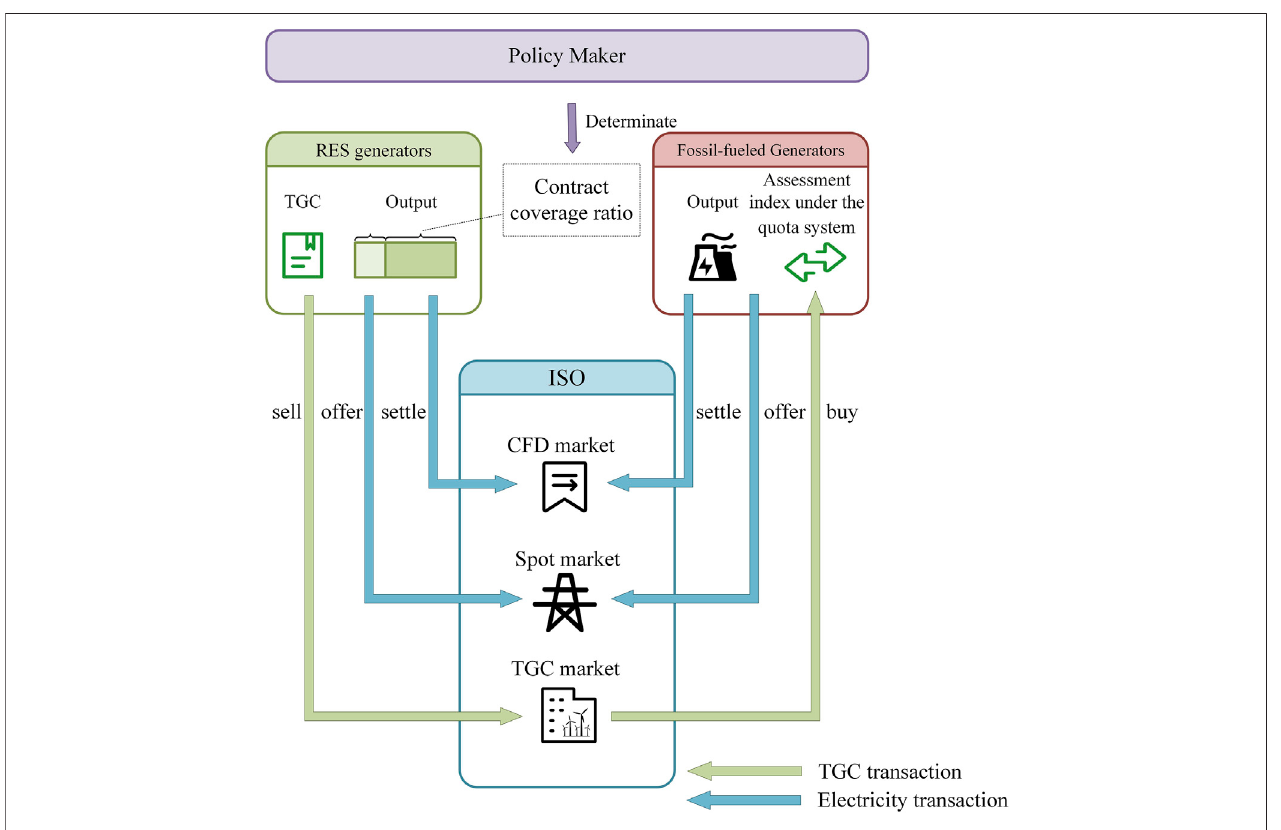
FIGURE 1 | Framework of market transactions considering RES unit